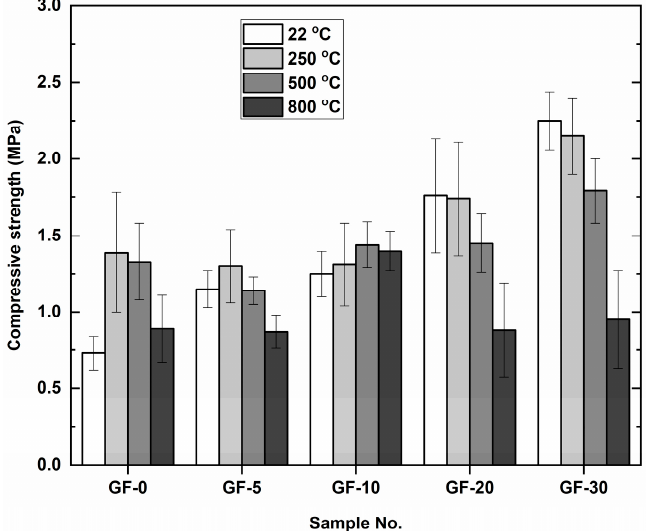
Figure 9. The compressive strength of the samples after being heated at elevated temperatures.